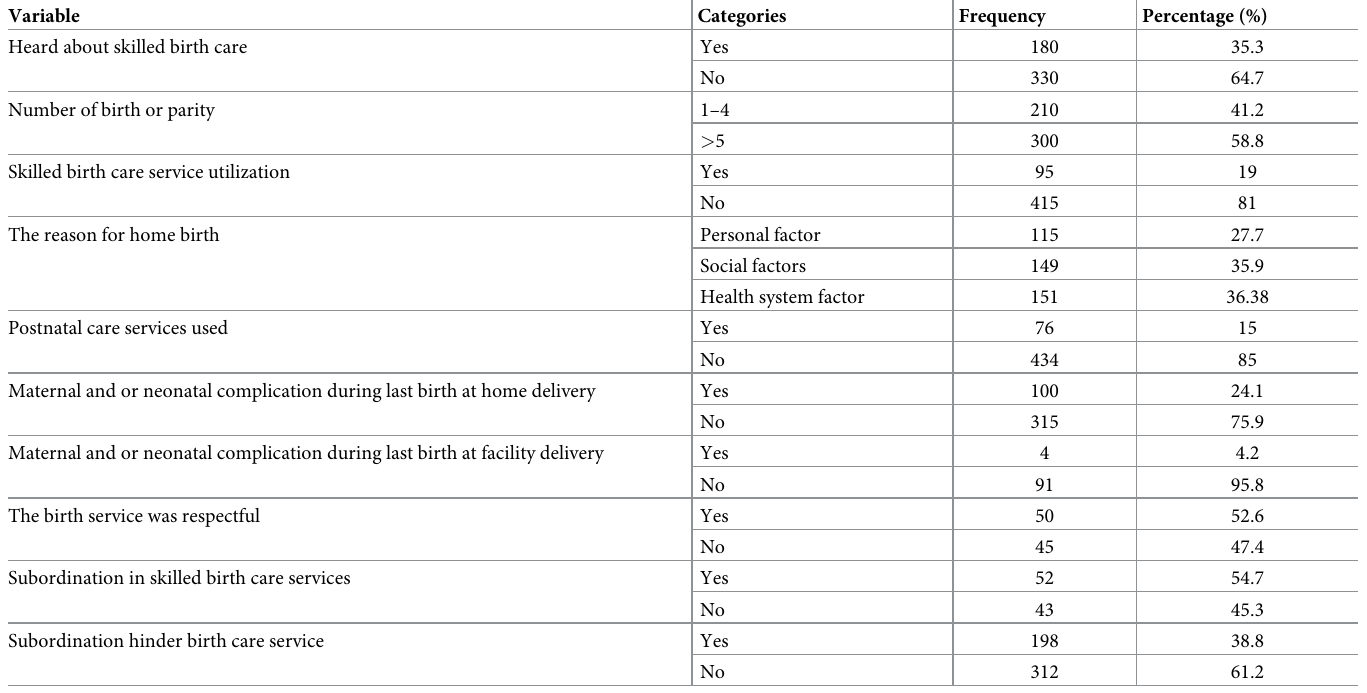
Table 2. Respondents’ skilled birth care service utilization in the Kambata-Temabaro Zone, Southern Ethiopia, 2019 [n =